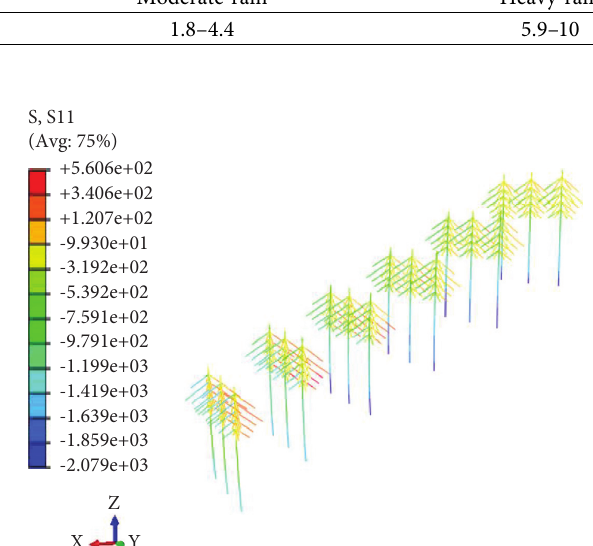
Figure 8: Stress distribution cloud diagram of the root of Magnolia